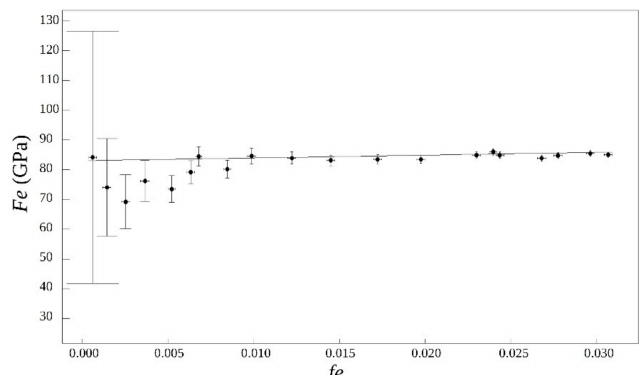
Figure 3. fe-Fe plot based on the data of wardite collected between 0.0001 and 9.08